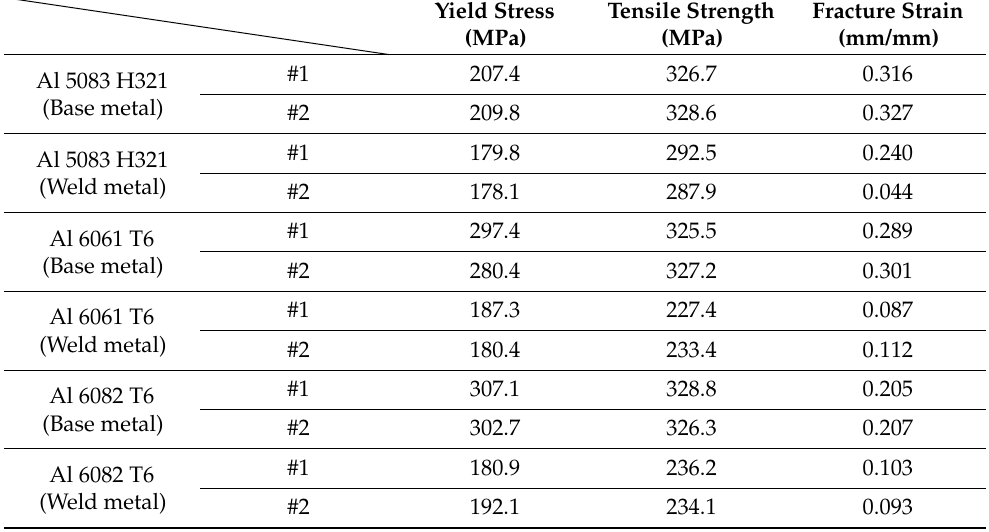
Table 8. Tensile test results (nominal stress and strain).